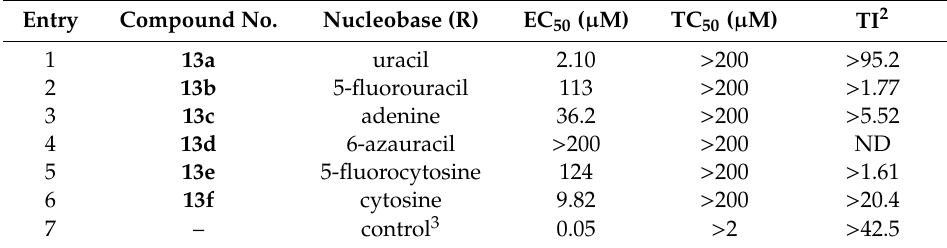
Table 1. Antiviral dose-response data for 2 (cid:48) - C -methyl-4 (cid:48) -thionucleoside phosphoramidates .1